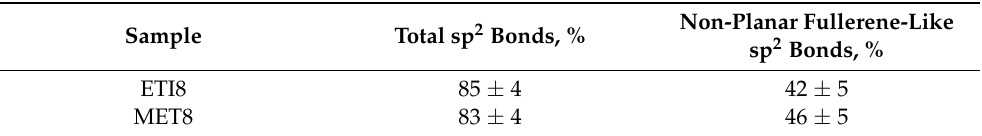
Table 1. Percentage of total sp 2 bonds and of non-planar fullerene like sp 2 bonds as calculated for ethylene young (ETI8) and methane young (MET8)